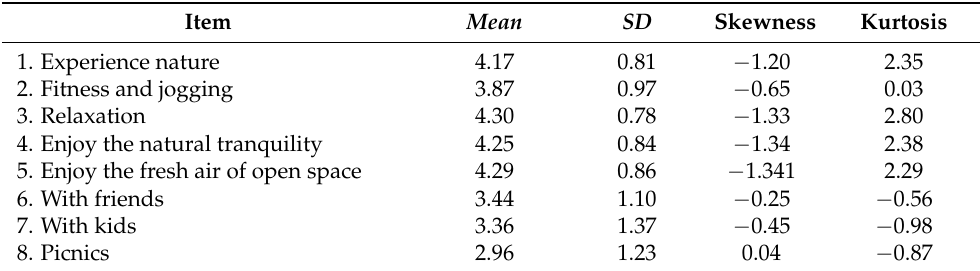
Table A11. Descriptive analysis of leisure motivations ( n = 1200, two samples combined).